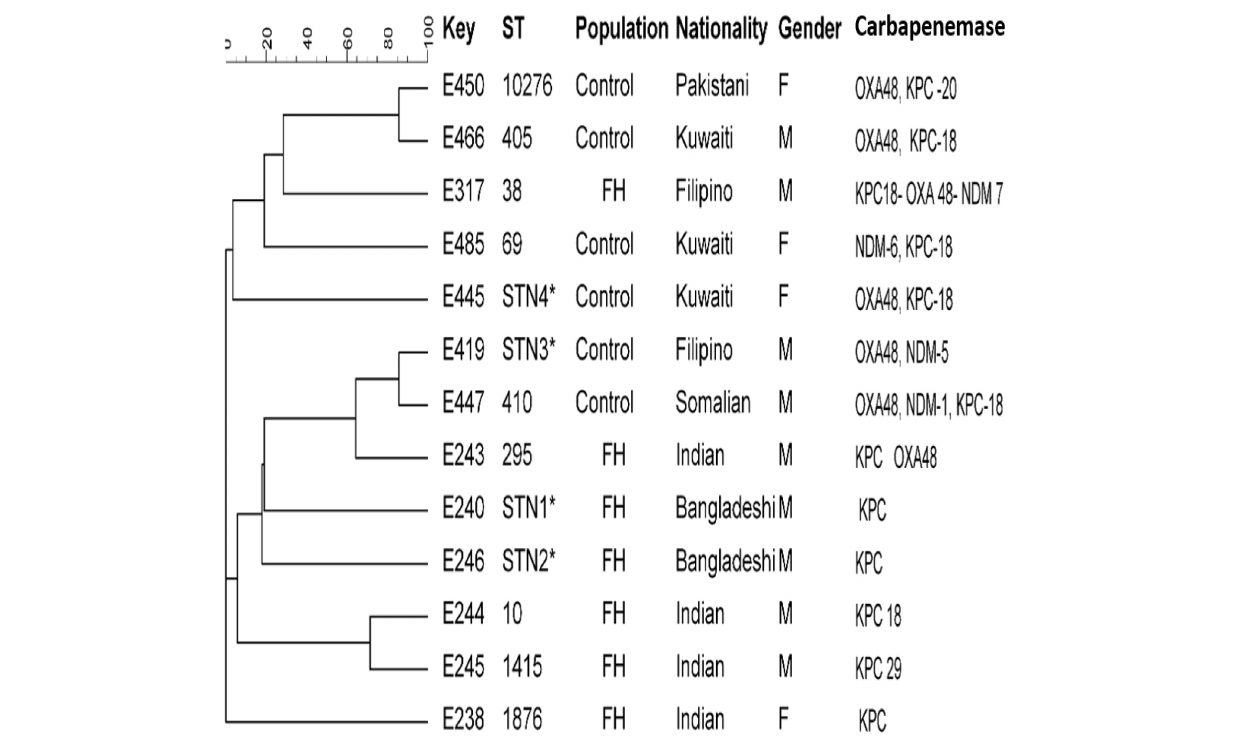
FIGURE 2 | Dendrogram of Escherichia coli obtained from food handlers and infected control patients showing clonal relatedness demonstrated by cluster analysis based on their MLST. The characteristics of the major clones generated using minimum spanning trees by BioNumerics software v6.1 (Applied Maths, Kortrijk, Belgium) are also highlighted. Similarity in the isolates is presented in percentages using the scale bar in the upper left corner. In the Key column, E represents E. coli , STs = sequence type; population = food handler (FH) and infected control patients; nationality; gender F = female, male = male; and carbapenemases. MLST, multilocus sequence